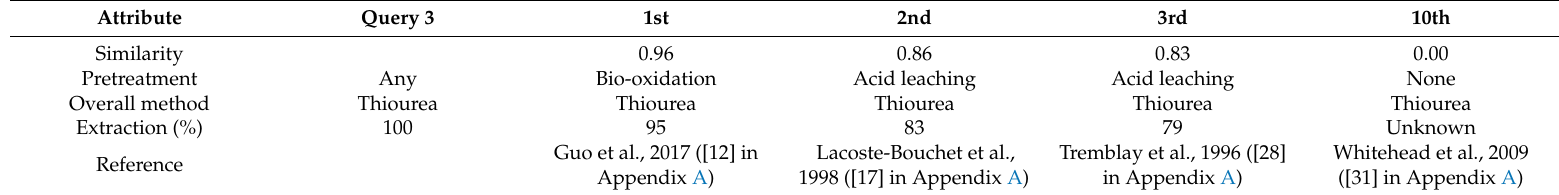
Table 7. Query 3 (Pretreatment and Thiourea) with the three most similar and the most dissimilar article retrieved from the case base.